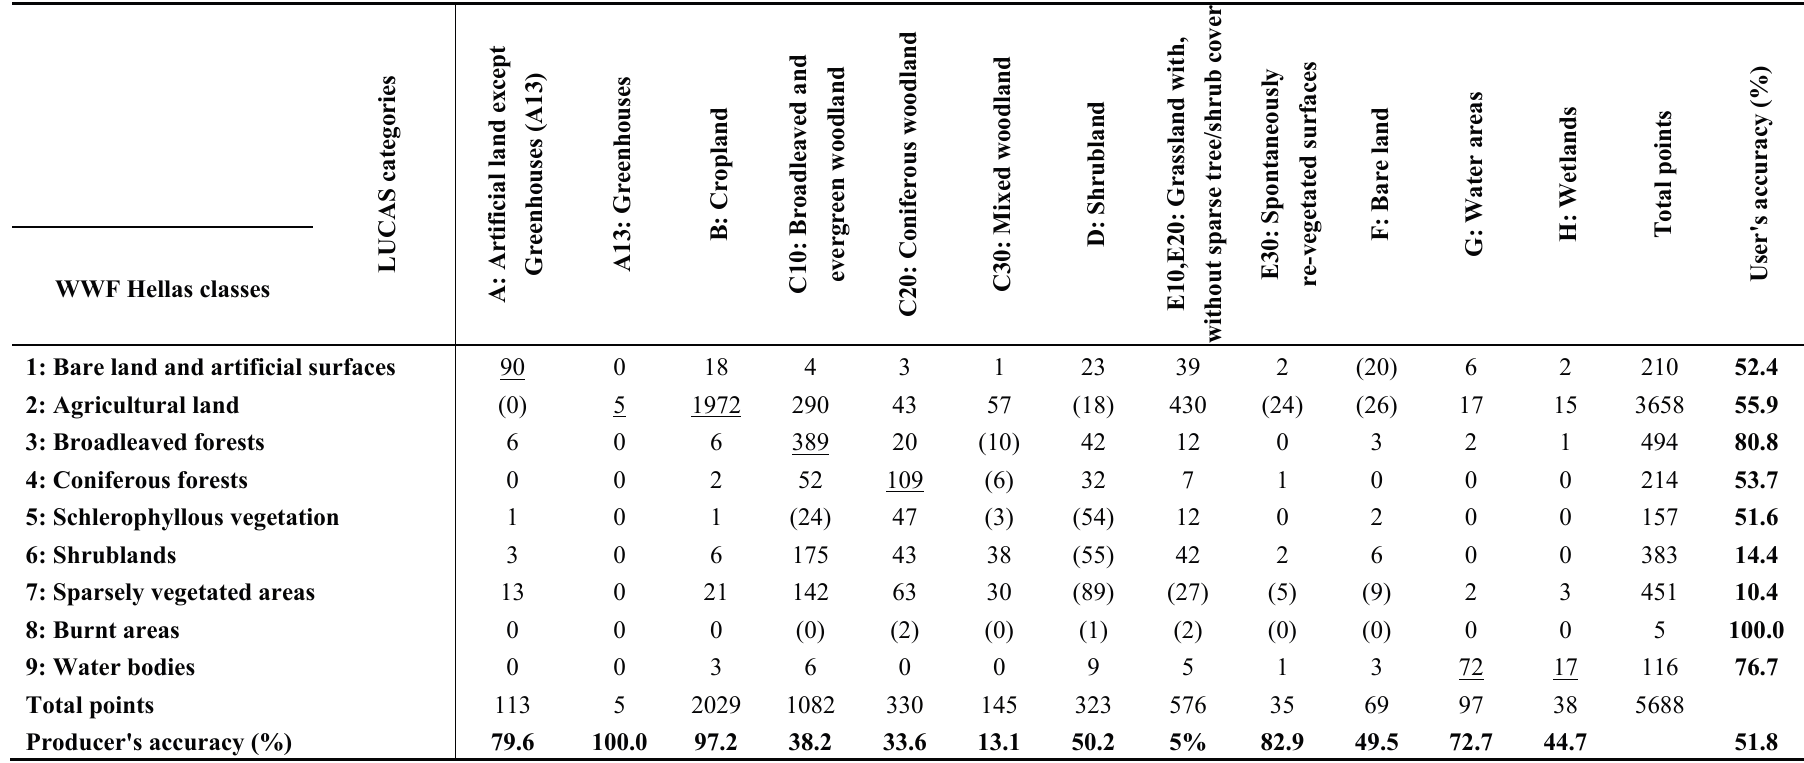
Table 6. The error matrix and accuracy totals of the supervised validation process (underlined numbers indicate points resulted from clear relations of agreement; number in brackets indicate interpreted